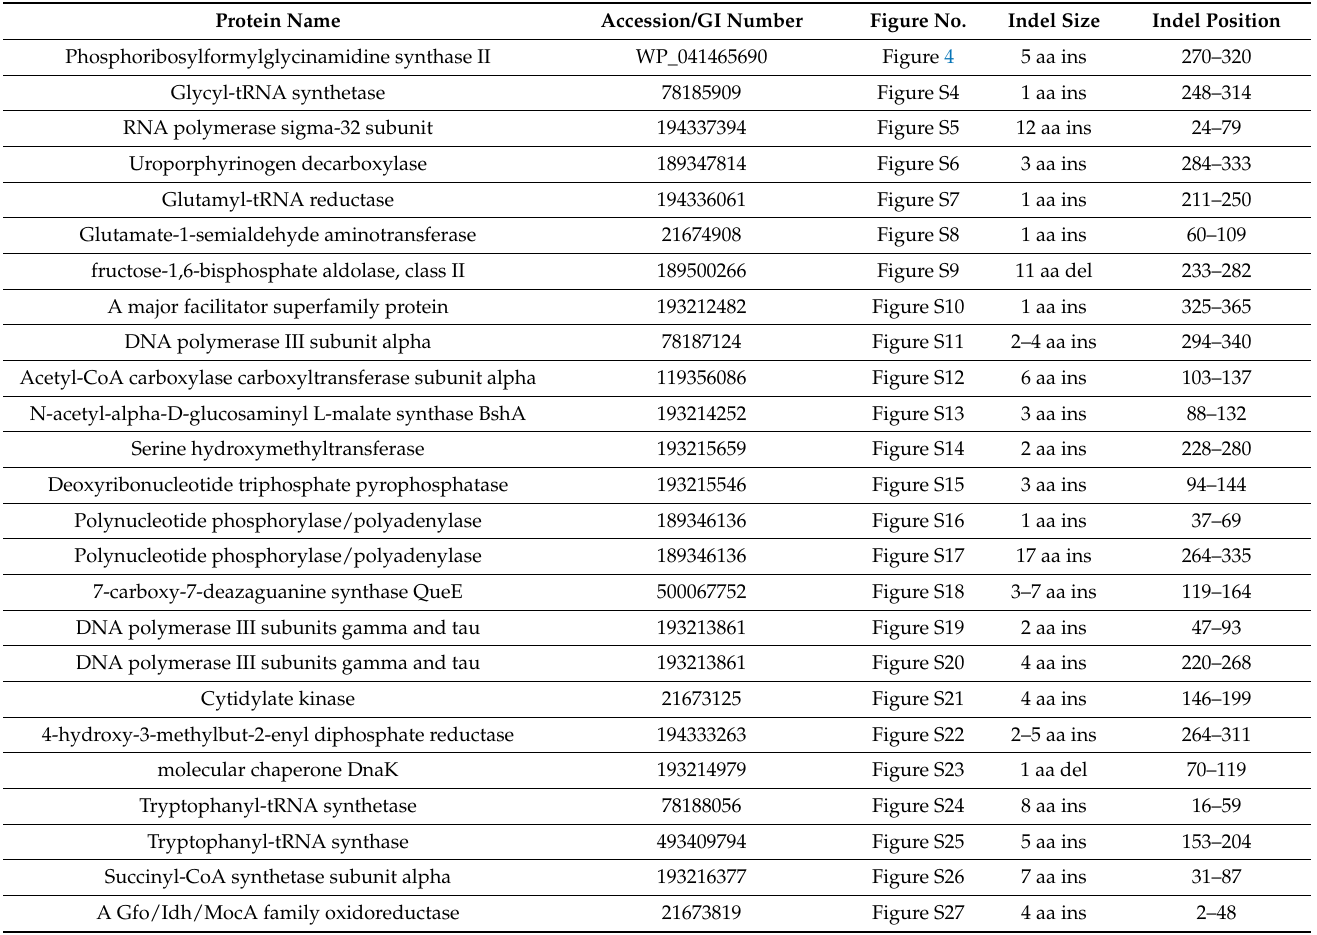
Table 1. Conserved signature indels specific for members of the order Chlorobiales * ,a